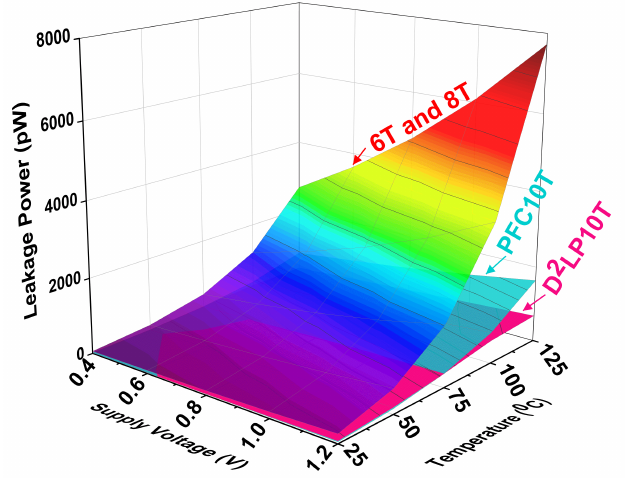
Figure 12. 3D plot of leakage power with supply and temperature